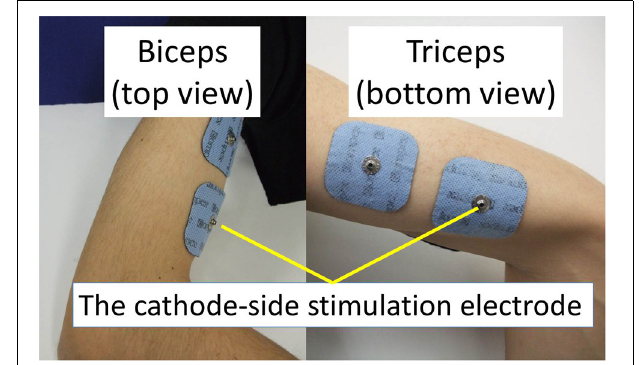
FIGURE 2 | Stimulation electrodes